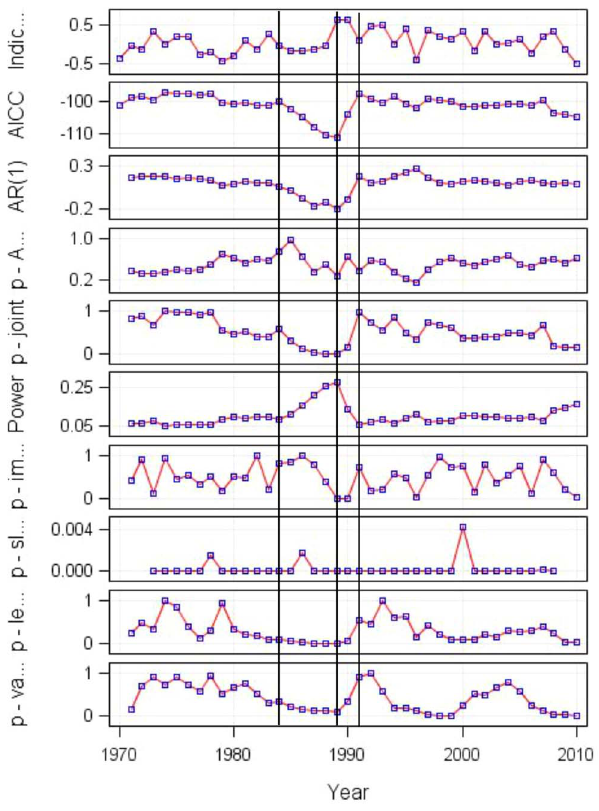
Figure 8. Shiftogram based on Baltic Sea Index in winter. The vertical lines indicate the position of shift and abbrevations in the Y-axis are from the top: i) plot of the time series analysed (Indic.), ii) quality-of- fit plot (AICC), iii) empirical first order autocorrelation coefficient of the model residuals (AR(1)), iv) p value of the first order autocorrelation coefficient (p-A.), v) joint significance relating all parameters (p-joint), vi) power plot to indicate the risk of false no-warning (Power), vii) statistical test detecting the impulse like shift (p-im.), viii) statistical test